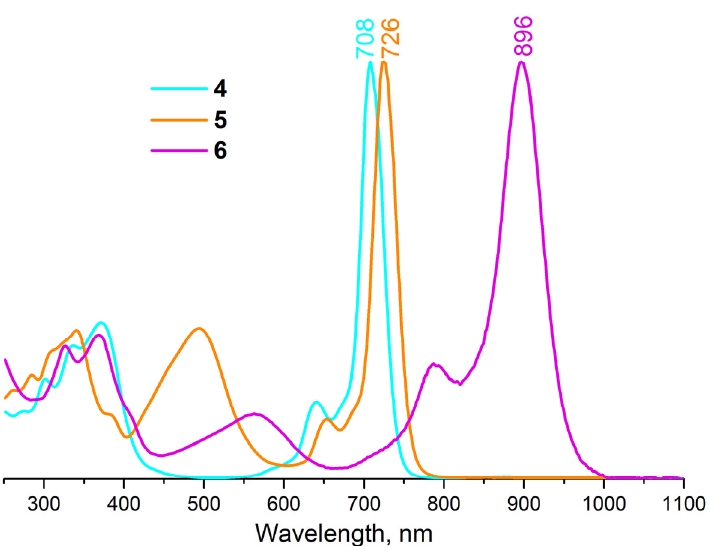
Figure 1. Normalized UV–vis spectra of P(V)Pcs with different type of substitution in DMSO. While complexes 4 , 5 , 6, and 8 exist as cations, complex 7 is an uncharged